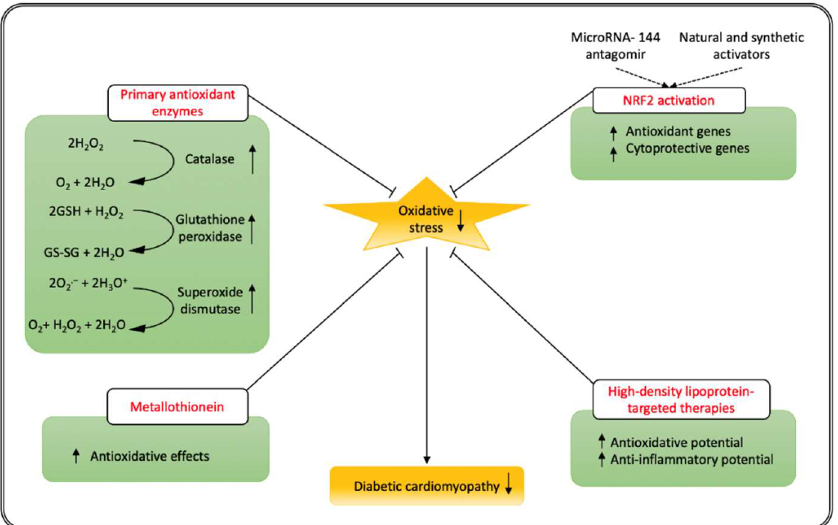
Figure 2 . Prevention and intervention studies directly supporting the role of oxidative stress in diabetic cardiomyopathy. Antioxidant strategies prevent the development of diabetic cardiomyopathy, supporting the central role of oxidative stress in the pathogenesis of this disorder. HDL-targeted therapies, increasing the anti-oxidative potential of HDL, not only prevent diabetic cardiomyopathy but also result in reverse remodeling and reversal of heart failure in pre-existing diabetic